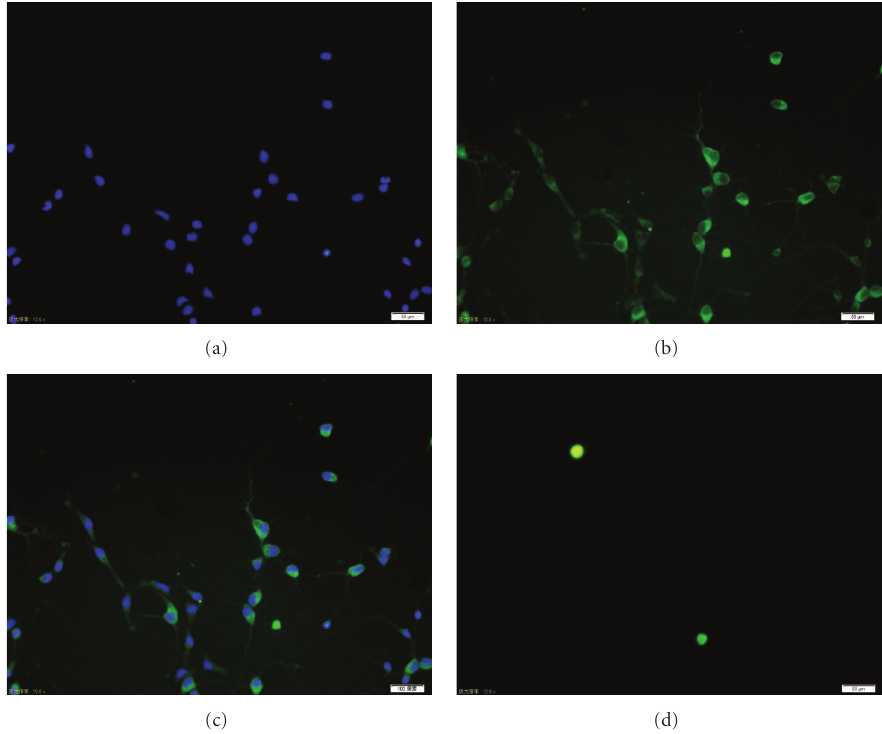
Figure 5: (a) DAPI+, (b) β -tubulin III+, (c) merge, and (d) negative